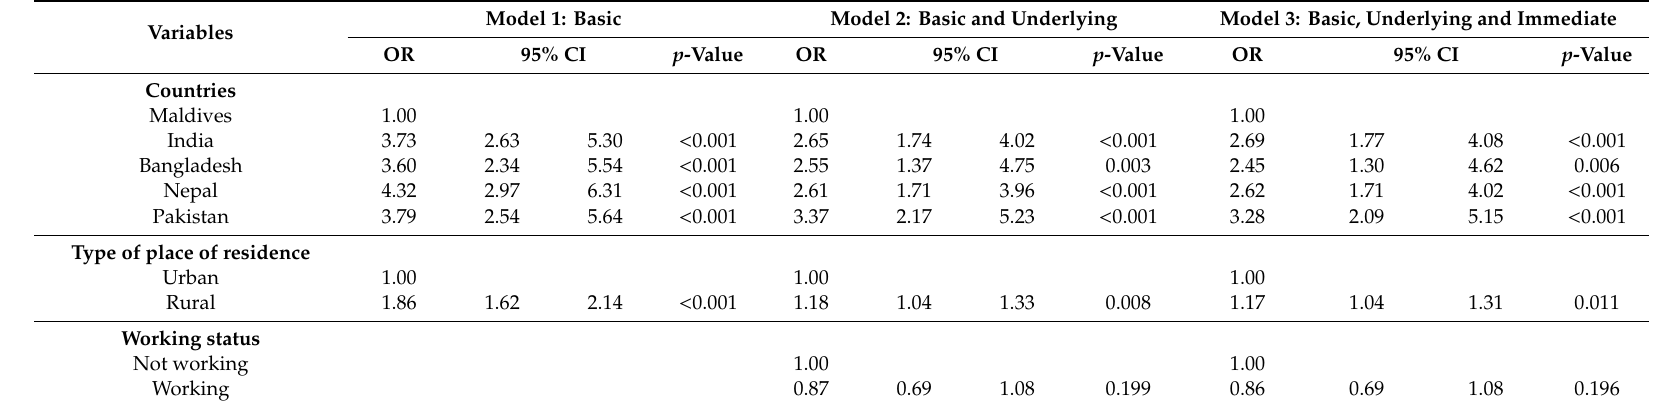
Table 2. Factors associated with stunting in children aged 24–59